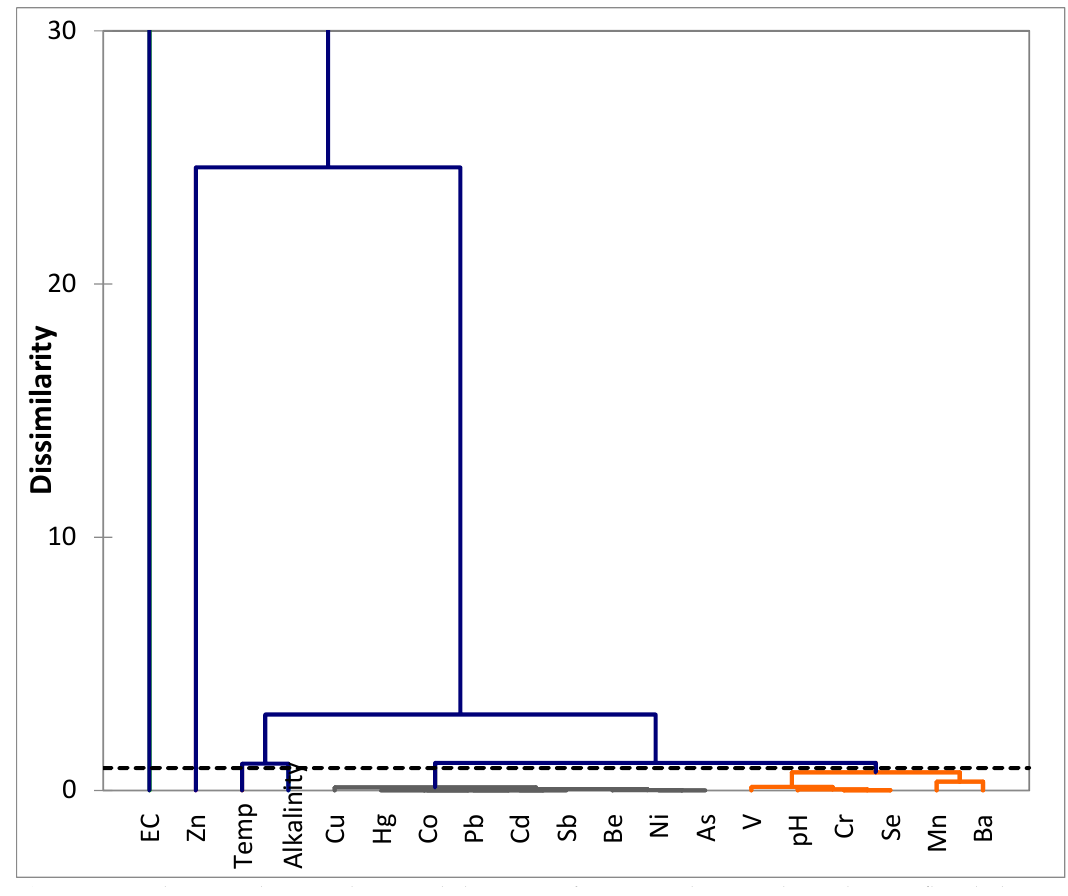
Table 6. Factor loadings of the trace metals concentrations and some physicochemical parameters.